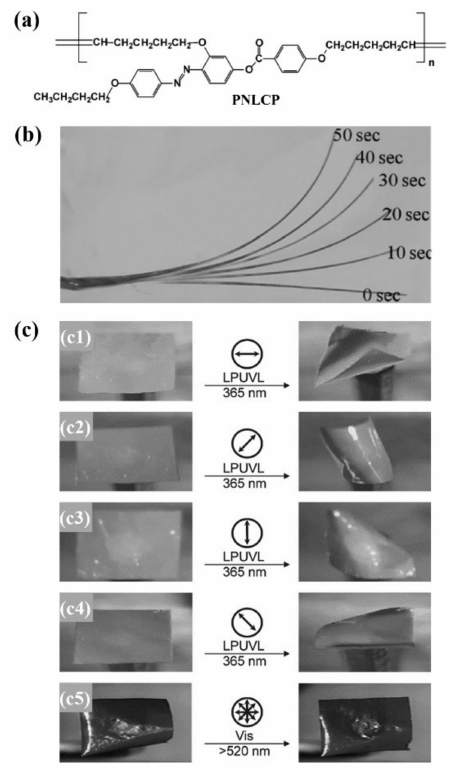
Figure 6. ( a ) Chemical structure of the photochromic LCP (PNLCP). ( b ) Superimposed photographic images of PNLCP fiber bending under UV irradiation. ( c ) Photographic images of precise control of bending direction using polarized light: ( c1 – c4 ) photomechanical bending of PNLCP films. Arrows in the circle indicate the direction of polarized light; ( c5 ) photomechanical unbending induced by visible light (>520 nm). Reprinted with permission from Reference [52]. Copyright 2009 Royal Society of